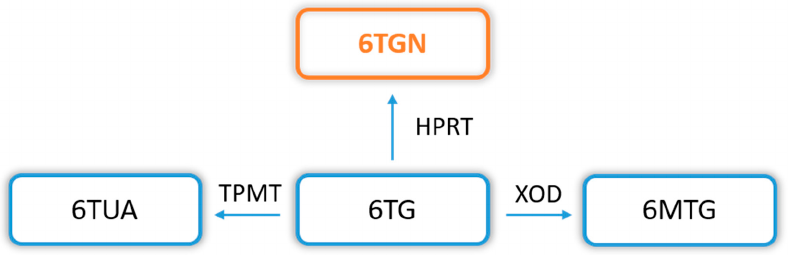
thine phosphoribosyltransferase; 6TGN—6-thioguanine nucleotides; XOD—xanthine oxidase/de- hydrogenase; 6MTG—6-methyl